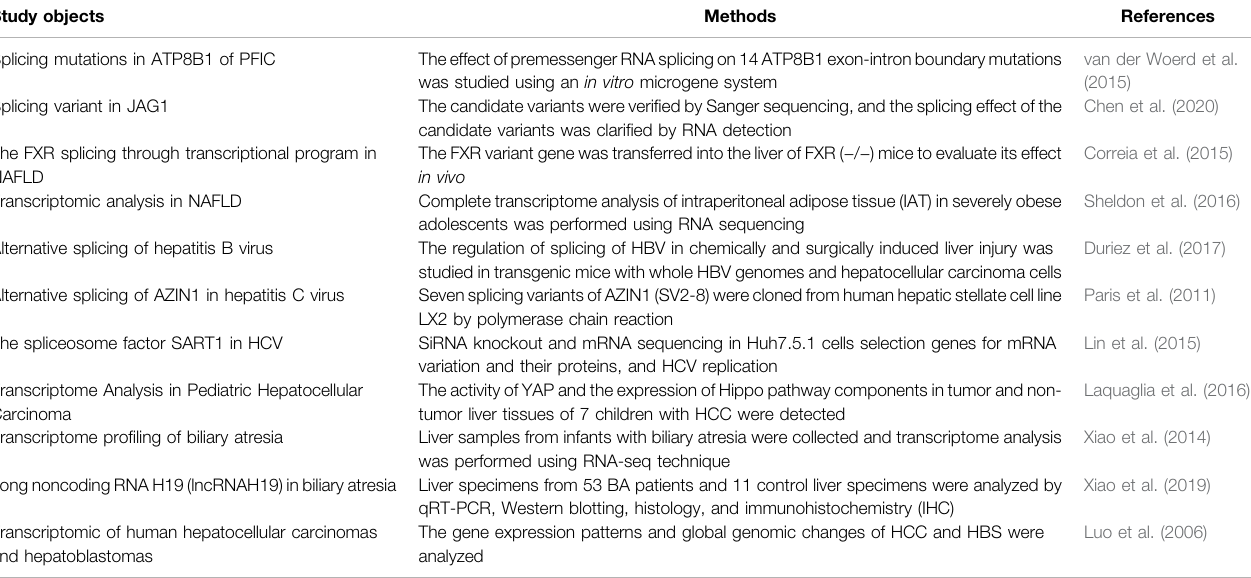
TABLE 1 | Studies reporting alterations of RNA splicing in pediatric liver